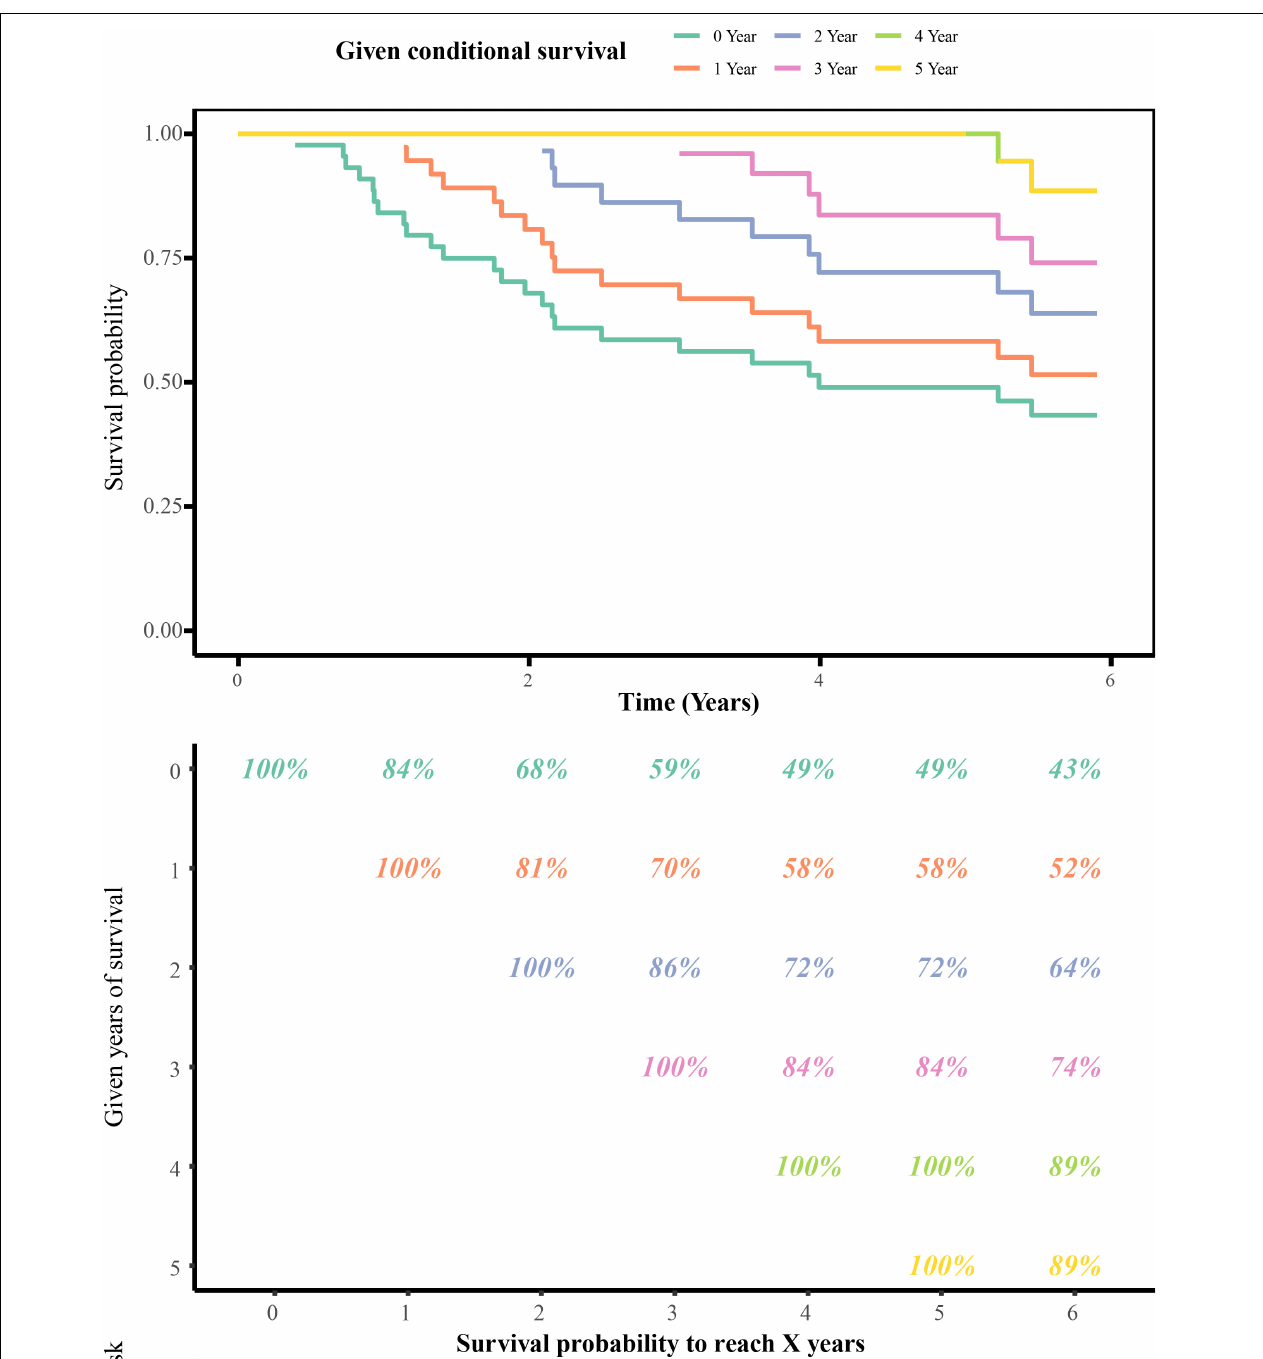
FIGURE 2 | Conditional survival estimates over time. Each column represents a survival period, and each row represents the percentage to reach a certain survival time from that point (in years).